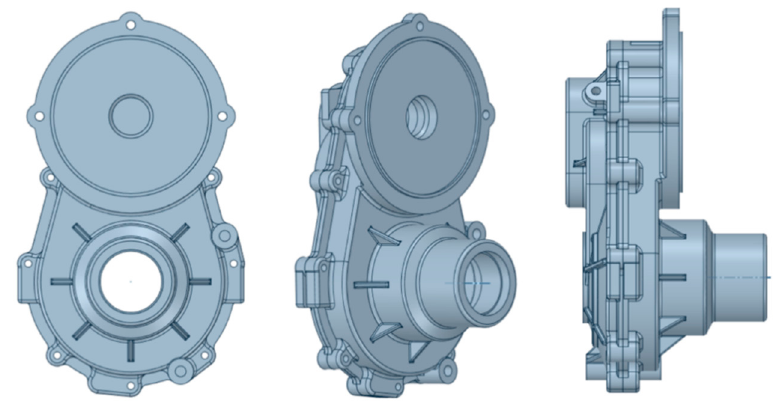
Figure 12. Modification model.